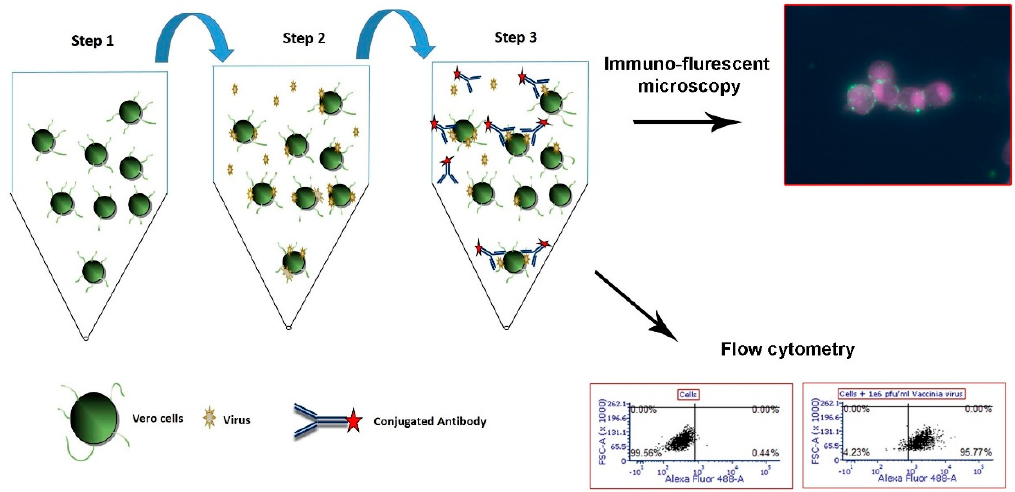
Figure 1. A schematic representation of the cell-based immuno-assay. Vero cells are harvested from cell culture flasks using trypsin (~15 min). The cells are then suspended in 2%FBS-MEM and aliquoted to tubes (step 1). The viruses are then added to the cells and incubated at 4 °C with shaking to allow adsorption to the cells surface (1 h) (step 2). After attachment to the cells, a specific fluorescent antibody is added (step 3, ~40 min) and the cells are analyzed in FACS or fluorescence microscopy. As an initial proof of concept, we tested this methodology for its ability to detect three different viruses: Modified Vaccinia Ankara (MVA), West Nile Virus (WNV) and Adenovirus. These viruses